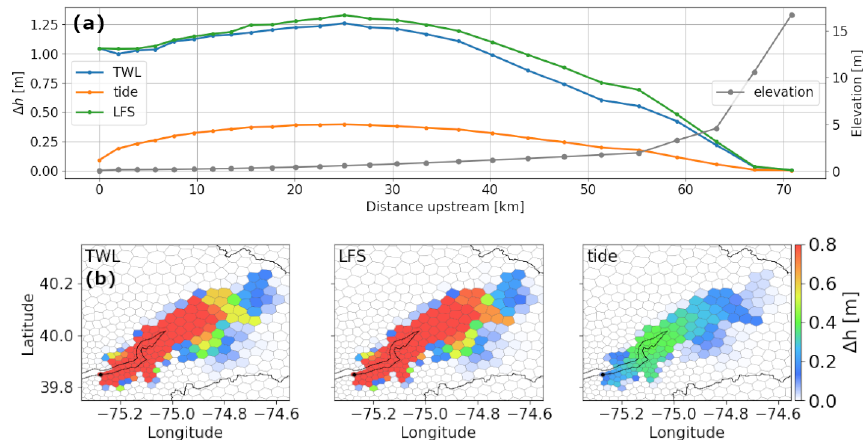
Figure 10. (a) The along-channel profiles of the maximum (cid:49)h obtained using the TWL, SS and tide configurations. The river outlet is at x = 0km. (b) The corresponding spatial map of the maximum (cid:49)h over a downstream region of Trenton. This region is specified as the red rectangles in Fig. 2. The black dots represent the Delaware River outlet.